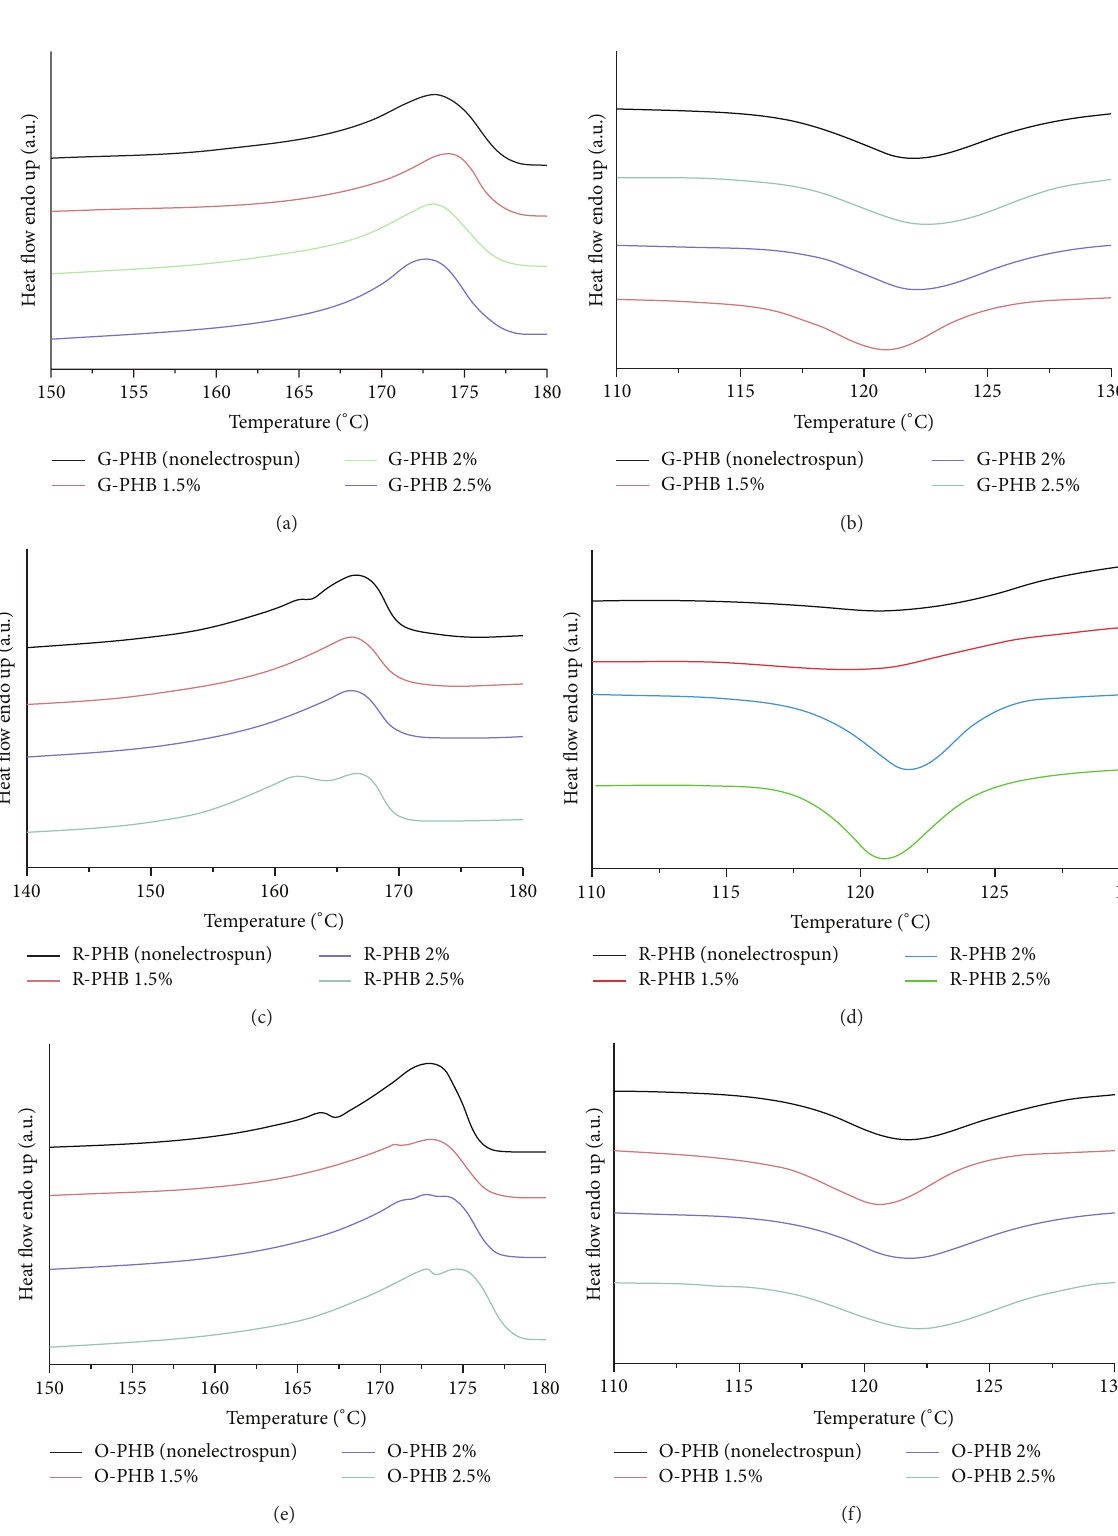
Figure 9: DSC trace for heating and cooling of electrospun and nonelectrospun samples of PHB at solution concentrations of 1.5%, 2%, and 2.5% (wt/v). (a), (b) represent the DSC trace on heating and cooling of G-PHB. (c), (d) represent the DSC trace on heating and cooling of R-PHB. (e), (f) represent the DSC trace on heating and cooling of